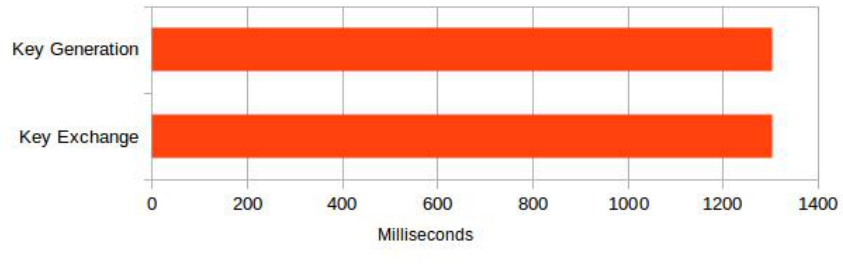
Figure 9. Shared secret establishment.